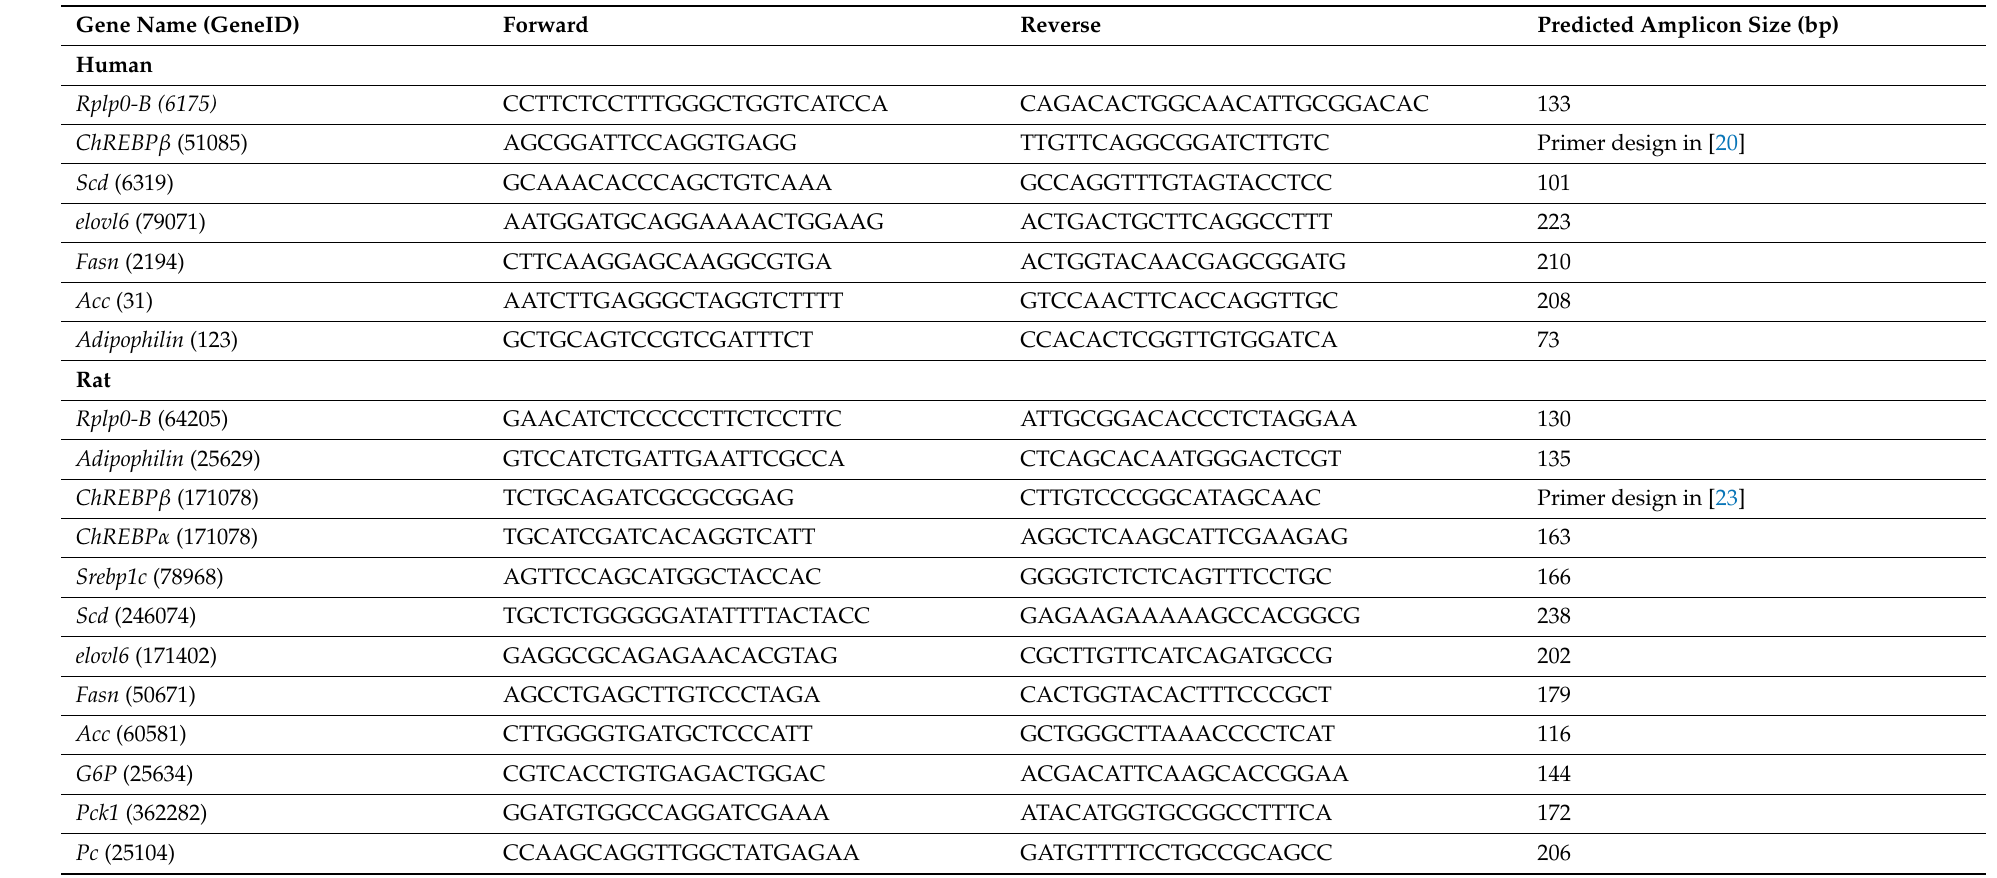
Table 2. Primers, including GeneID, predicted amplicon size (bp), and abbreviations